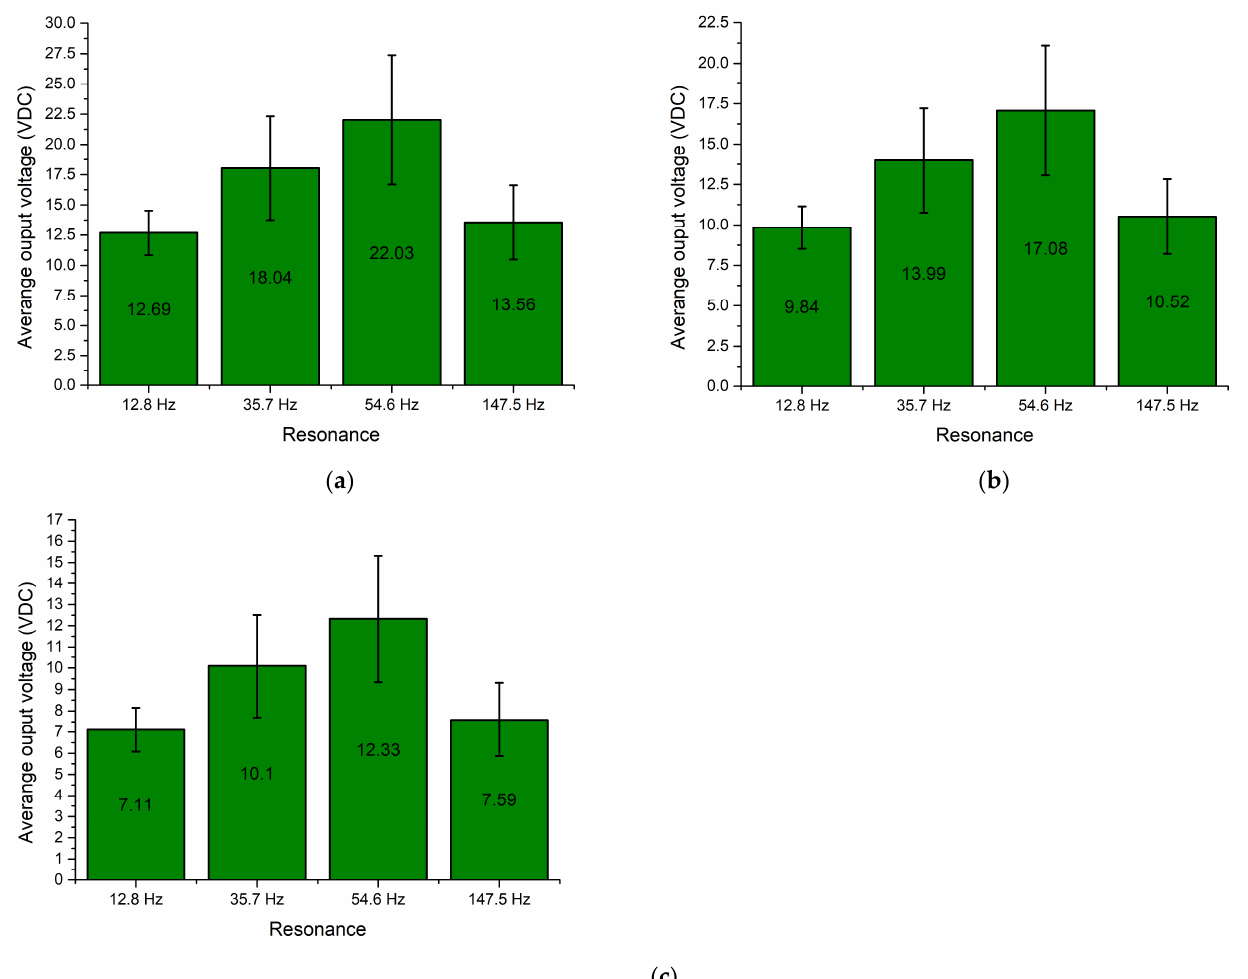
Figure 19. Summary of average output voltages at resonance frequencies while different loads are used; ( a )—load equal to 1 MΩ; ( b )—load equal to 500 kΩ; ( c )—load equal to 250 kΩ.